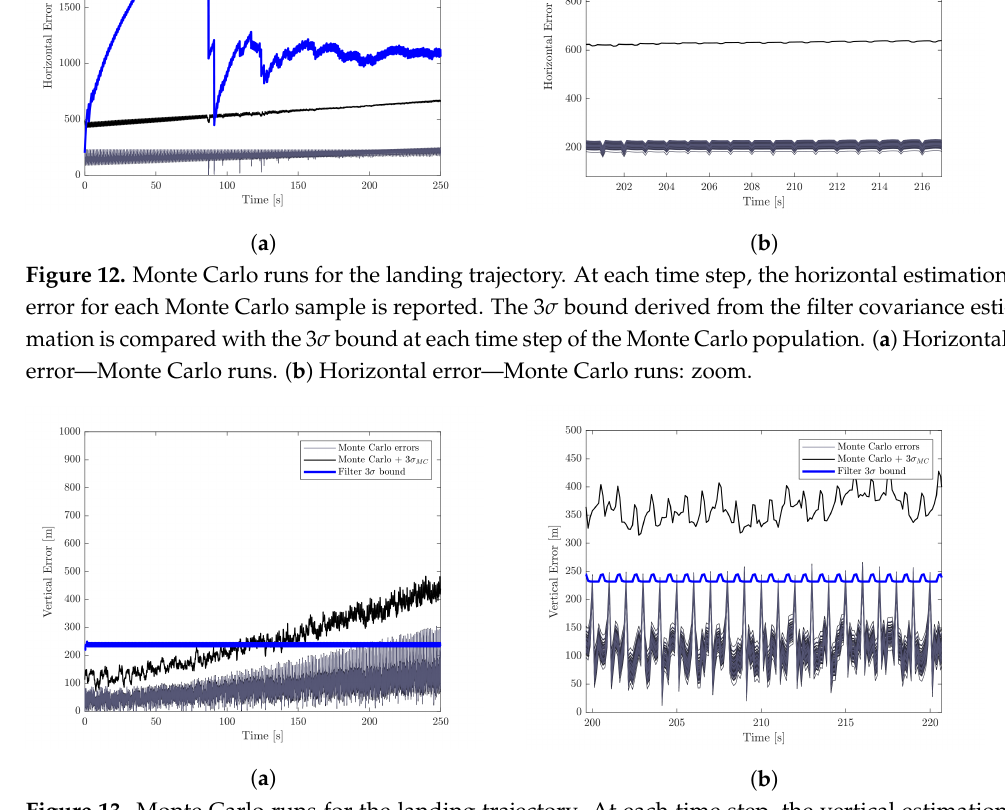
Figure 13. Monte Carlo runs for the landing trajectory. At each time step, the vertical estimation error for each Monte Carlo sample is reported. The 3 σ bound derived from the filter covariance estimation is compared with the 3 σ bound at each time step of the Monte Carlo population. ( a ) Vertical error—Monte Carlo runs. ( b ) Vertical error—Monte Carlo runs: